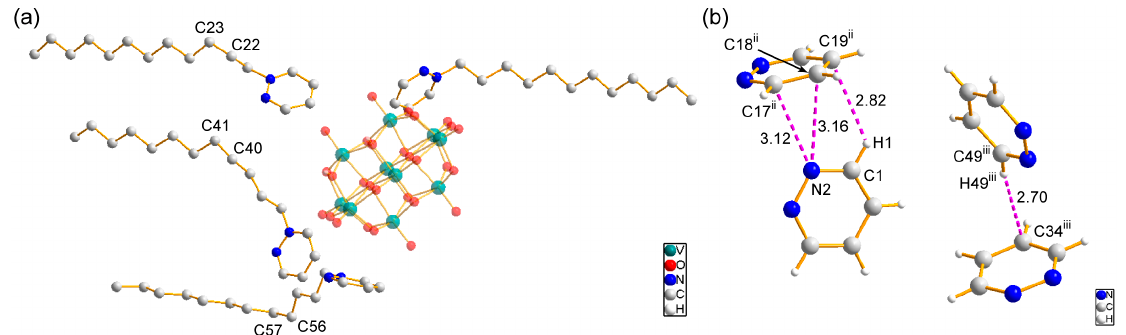
Figure 5. View of crystallographically-independent surfactant molecules; ( a ) whole C 12 pda cations in the asymmetric unit together with V 10 anion; ( b ) pyridazinium moieties of the C 12 pda cations in the vicinity of the V 10 anions. The distances of short contacts are represented in Å unit. Symmetry code: ( ii ) 1 − x , 1 − y , 1 − z ; ( iii ) x , 1.5 − y , 0.5 + z .